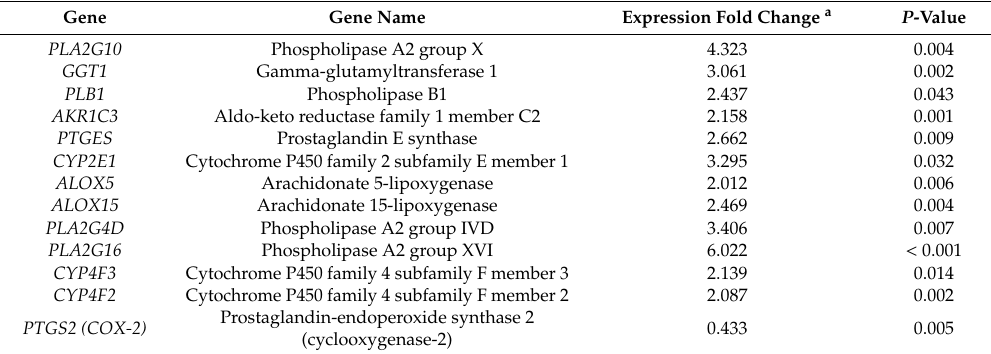
Table 2. Genes involved in arachidonic acid metabolism network by STRING analysis.